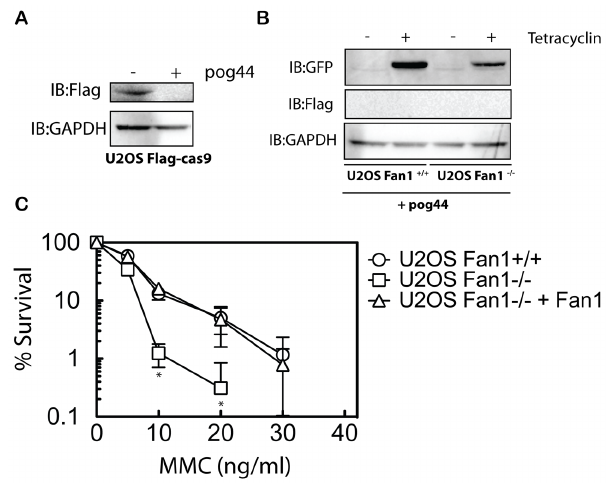
Figure 3. Recombination-based complementation of FAN1 knockout cells. ( A ) U2OS SEC-C FAN1 2 / 2 cells were transfected or not with the plasmid pOG44 expressing the Flp recombinase. After 5 passages underzeocinselection,cellextractsweresubjectedtowesternblottingwith anti-FlagantibodiestocheckfortheeliminationoftheCas9ORF.( B )Lysates fromFlp-In T-REx U2OS FAN1 2 / 2 cells transfected or not with the plasmids pOG44 and pCDNA5-FRT-GFP-FAN1 were subjected to western blotting with the indicated antibodies. ( C ) Clonogenic survival analysis of the cells U2OS FAN1 + / + (clone 2) U2OS FAN1 2 / 2 (Clone 1) and U2OS FAN1 2 / 2 + FAN1 (Clone1 complemented) after exposure to MMC. For eachgenotype, cell viability of untreated cells is defined as 100%. Data are represented as mean 6 SEM, n= Experimental significance was calculated using a unpaired T-test correct using Holm-Sidak method; *, p , 0.01.